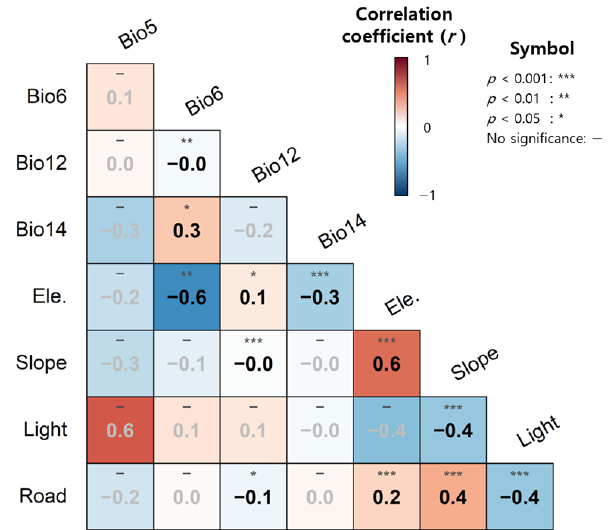
Figure 3. The relationship between the environments in the occurrence sites of WCSBs. Spearman’s correlation analysis was used. The numbers in the figure mean correlation coefficient ( r ). Gray letters indicate statistically insignificant relationships ( p ≥ 0.05). Bio5: maximum temperature of the warmest month; Bio6: minimum temperature of the coldest month; Bio12: annual precipitation; Bio14: precipitation of driest month; Ele: elevation; Light: night light; Road: distance to the road. 3.2. Prediction of WCSB Occurrence Using SDMs The RF and MaxEnt models predicted the potential occurrence areas of WCSBs based on environmental conditions. Both SDMs showed good predictability (mean ± standard error) with accuracies of 0.863 ± 0.016 and 0.856 ± 0.016, respectively, in the RF and MaxEnt